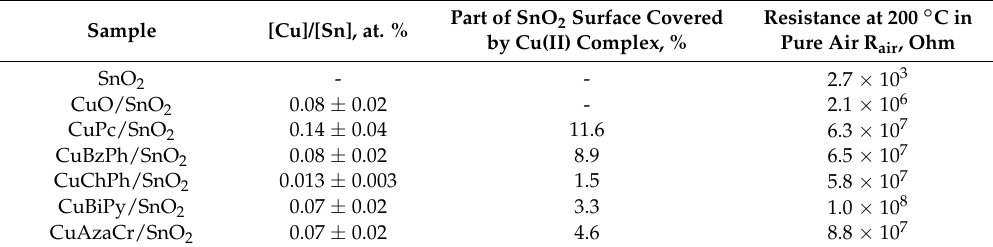
Table 2. Samples designation, composition, and resistance in pure air.